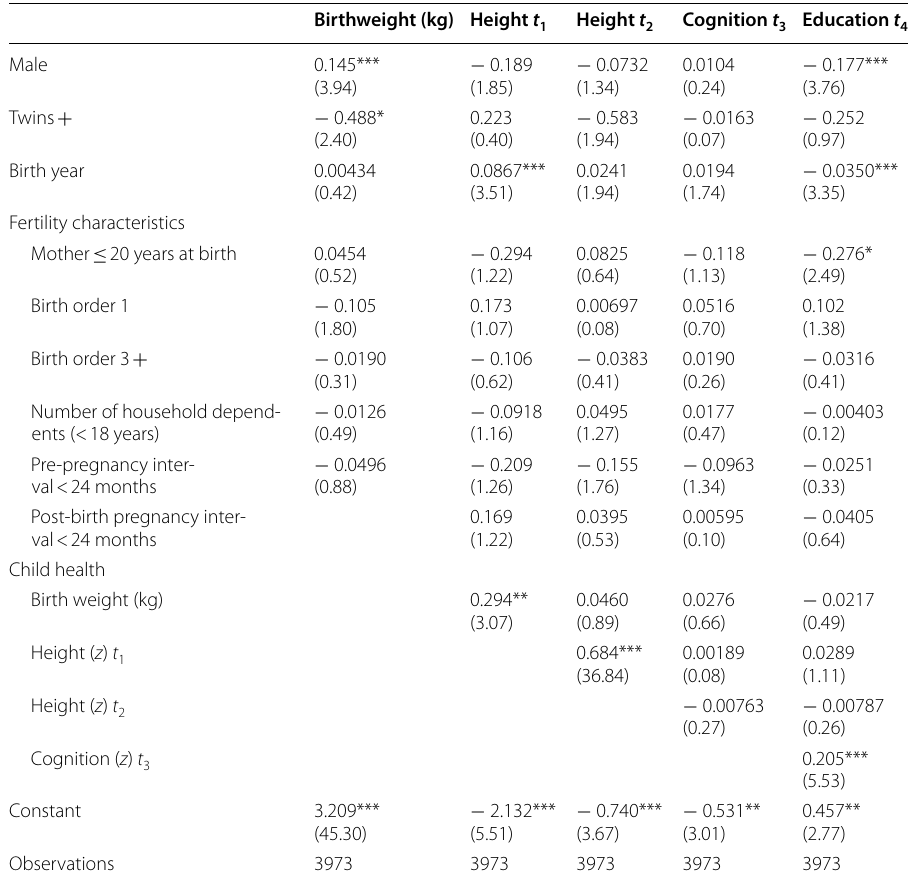
Table 4 Maternal fixed effects model